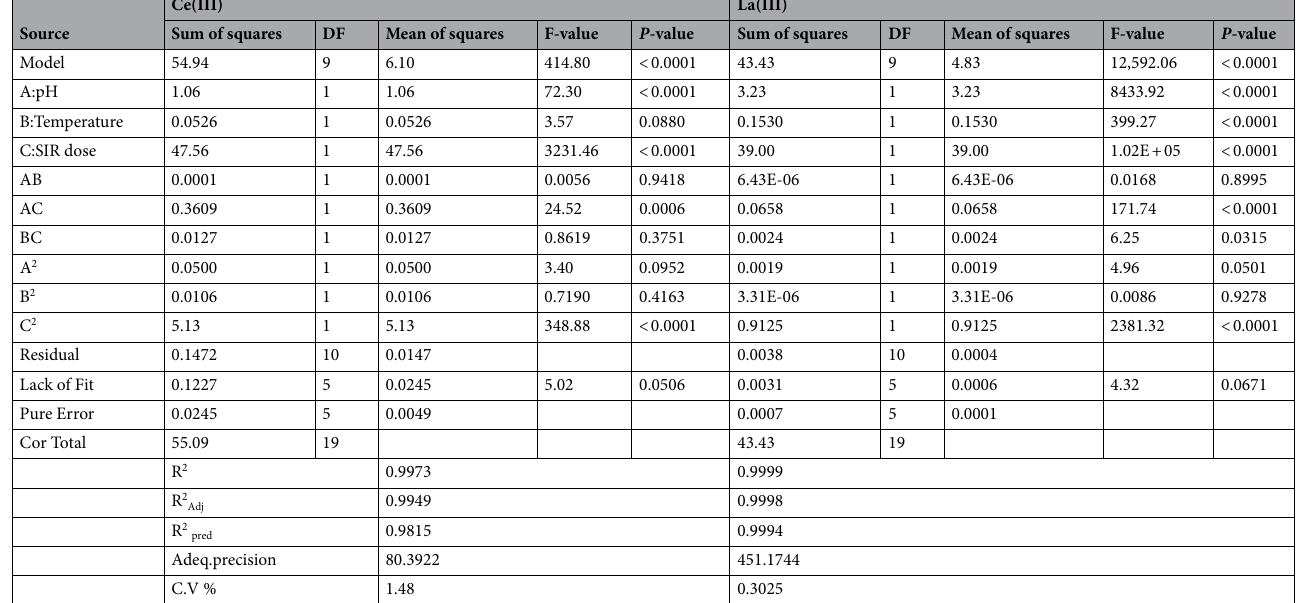
Table 5. ANOVA for quadratic model